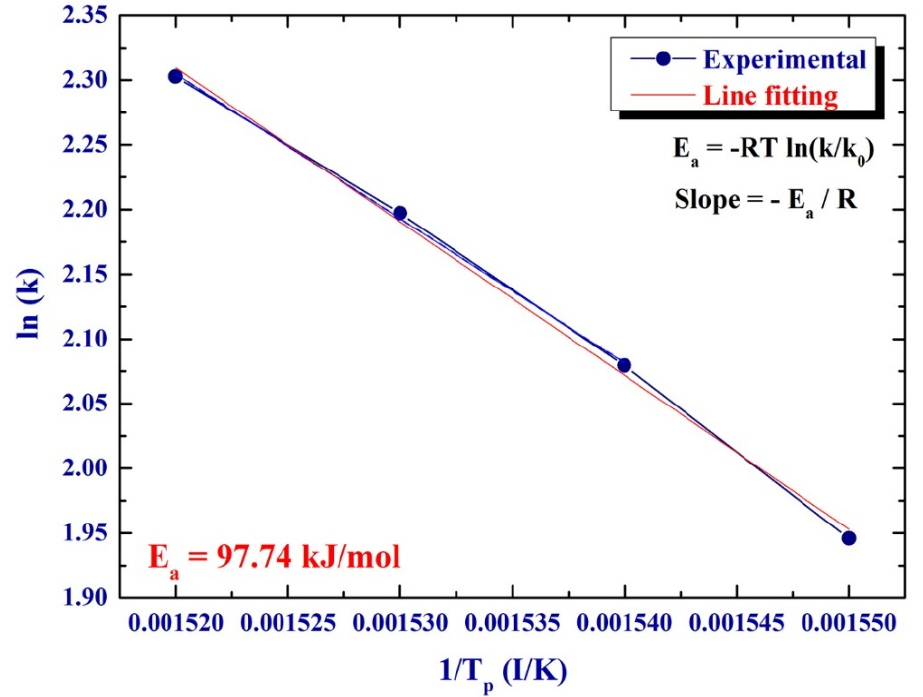
Figure 5. Arrhenius plot displayed the natural logarithmic values of the heating rates ( k ) versus the inverse of the peak temperature (1/ T p ) denoted in the DSC curves of Figure 4.